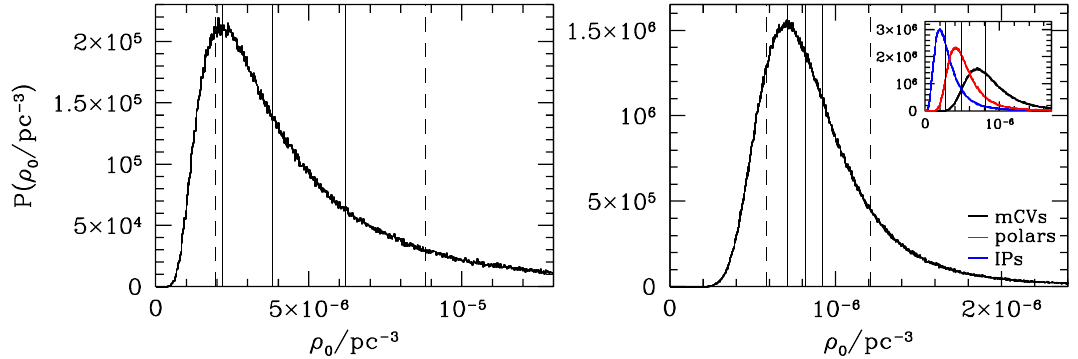
Figure 3: The ρ distributions for non-magnetic CVs (left-hand panel) and mCVs (right-hand panel) resulting from our simulations. Solid lines in both panels mark the modes, medians, and means of the distributions; dashed lines show 1- σ intervals. The probability distribution functions shown in the inset are for the whole mCV sample, polars alone (red), and IPs alone (blue). Reproduced from Pretorius & Knigge (2012) and Pretorius, Knigge & Schwope (2013).